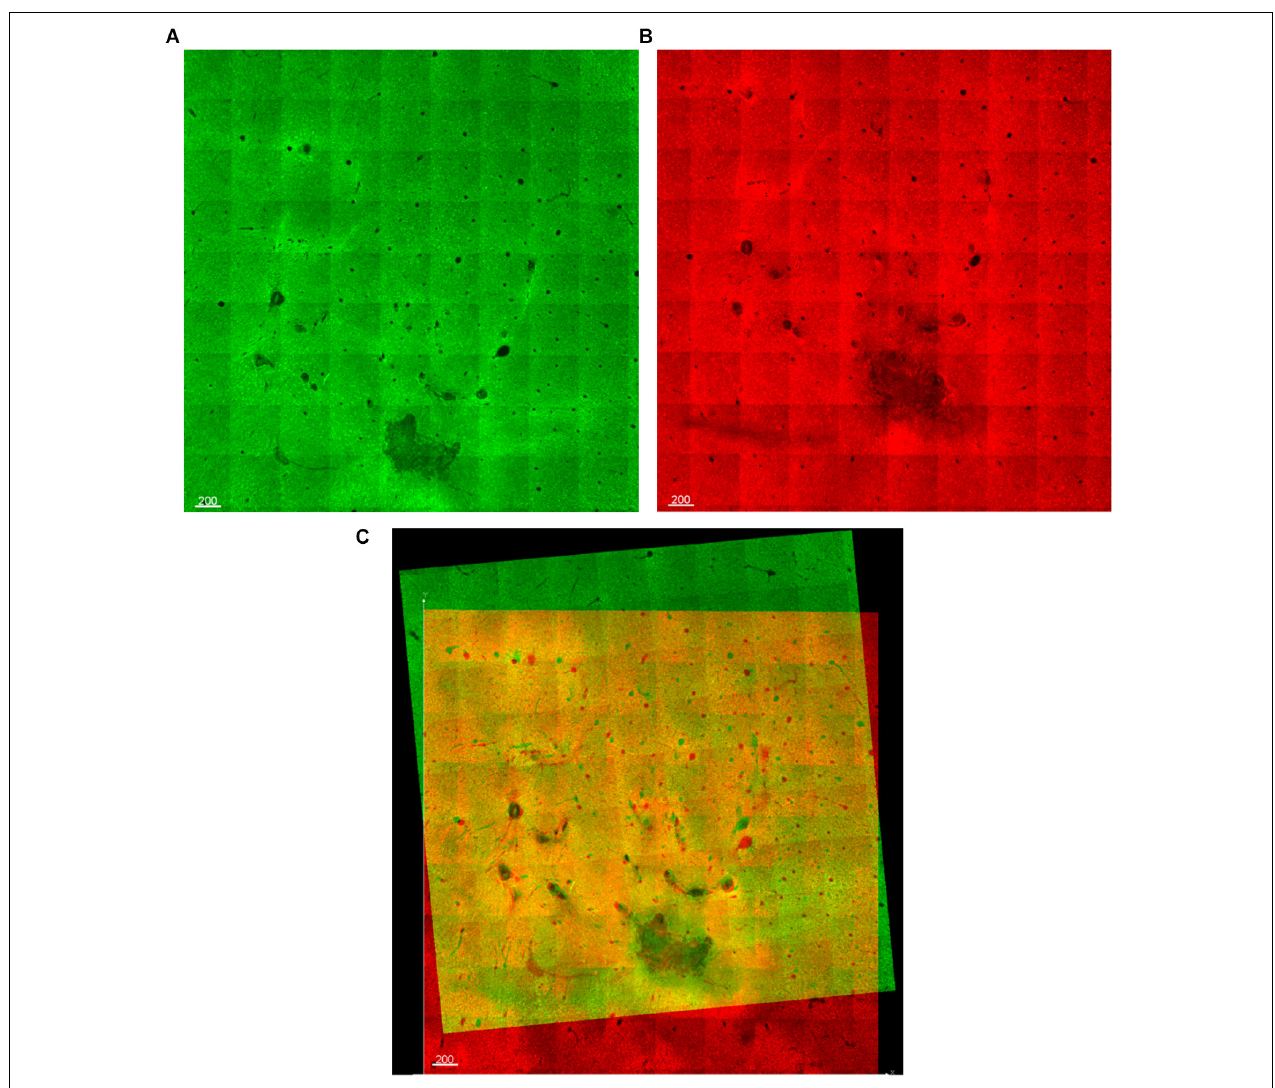
FIGURE 5 | (A,B) Two optical slices from vertically-consecutive sections. One is shown in green, the next in red. (C) During alignment, the red and green images are overlaid, allowing fiducials (electrode tracks) to be manually aligned.